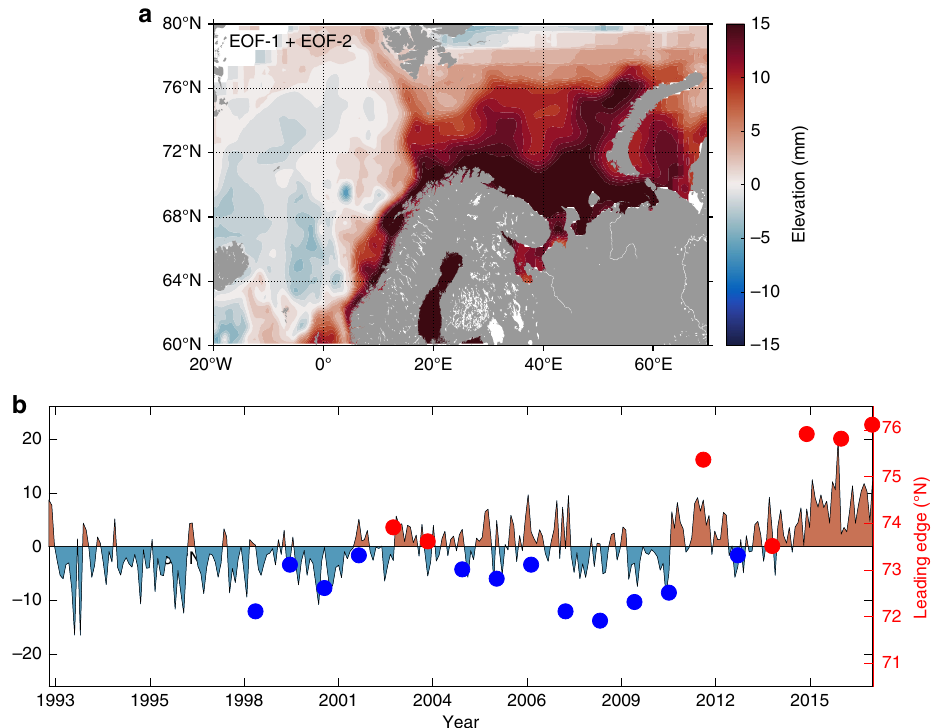
Fig. 2 EOF analysis of the MSLA in the European Arctic Corridor. The sum of the fi rst two modes ( a ) account for more than 80% of the total variability. The associated time-series ( b ) experiences a positive linear trend. The blue/red dots correspond to the latitude of the leading-edge of the Ehux blooms in the eastern Barents Sea for longitudes > 40°E (right red y -axis), which strongly correlates with the yearly averaged EOF-1 + EOF-2 time-series (r = 0.77, p = 0.0002, two-sided t